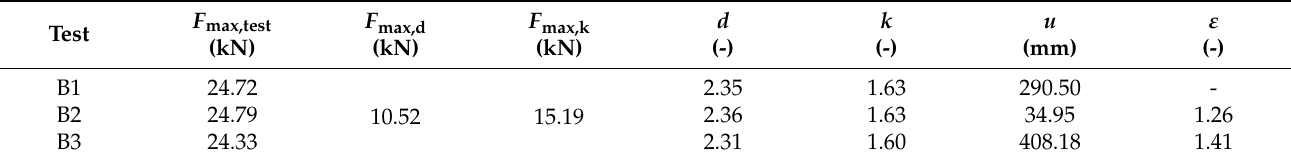
Table 6. Results of experiment B, using full-threaded screws. Table 8. Comparison of ductility results of experiments.